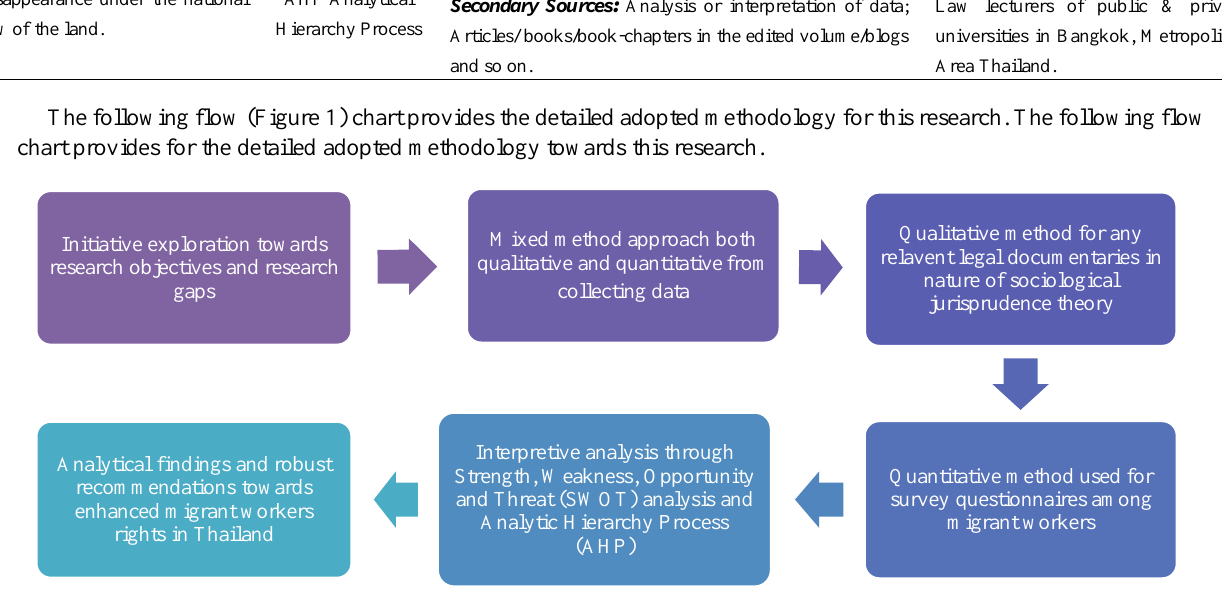
Figure 1. Flow chart of research